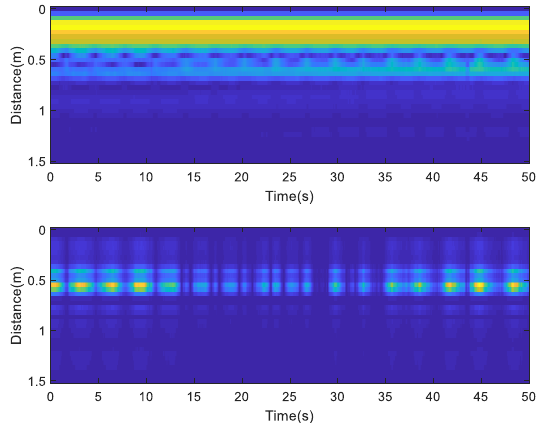
Figure 4. Before and after radar echo reconstruction.